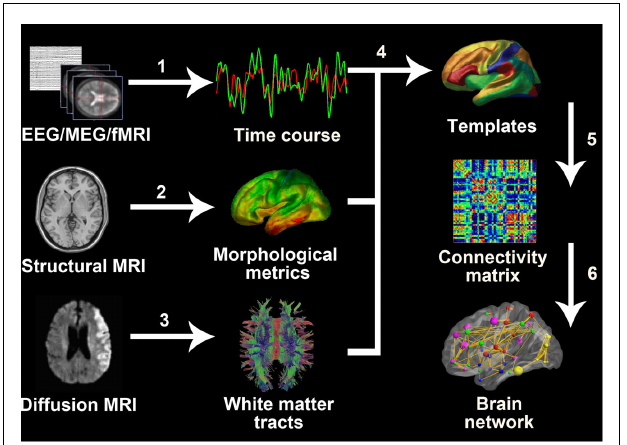
FIGURE 1 | General process of whole-brain network construction. 1, Extract time course from EEG/MEG records or fMRI images. 2, Calculate morphological metrics such as cortical thickness (the picture showed in Figure 1 ) and gray matter volume. 3, Define white matter fiber bundles using tractography. 4, Extract regional information from the original voxel- or vertex-based MRI data according to templates. 5, For EEG/MEG, fMRI, and sMRI, the connectivity matrix usually refers to the correlation matrix; for diffusion MRI, it can be a matrix consisting of numbers of fibers regions or the connectivity strength. 6, Generate the whole-brain network using further modification of the connectivity matrix, for example by using